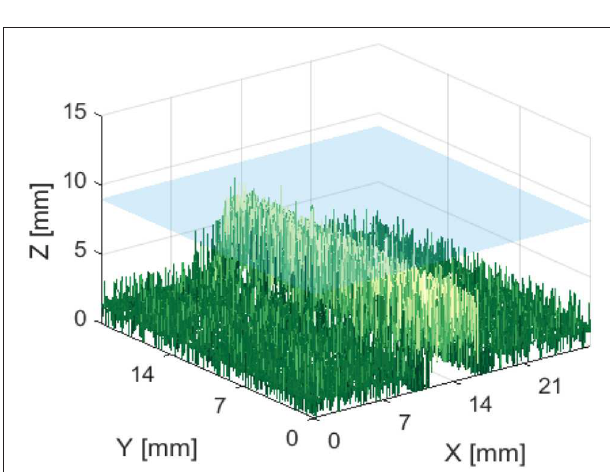
FIGURE 13 | Reconstructed depth map for a capillary phantom 5mm below the surface of soft tissue emulate, shown in blue.